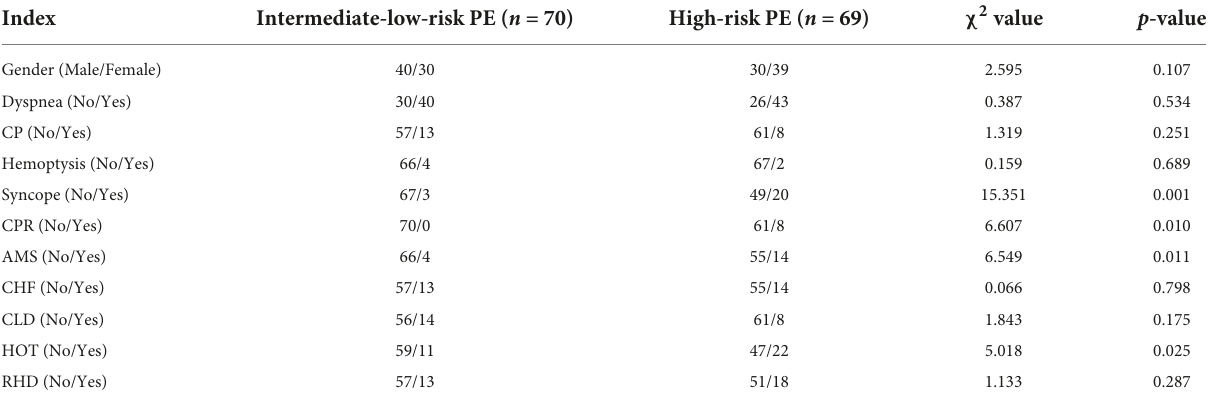
TABLE 2 Clinical characteristics in intermediate-low-risk PE patients and high-risk PE patients.